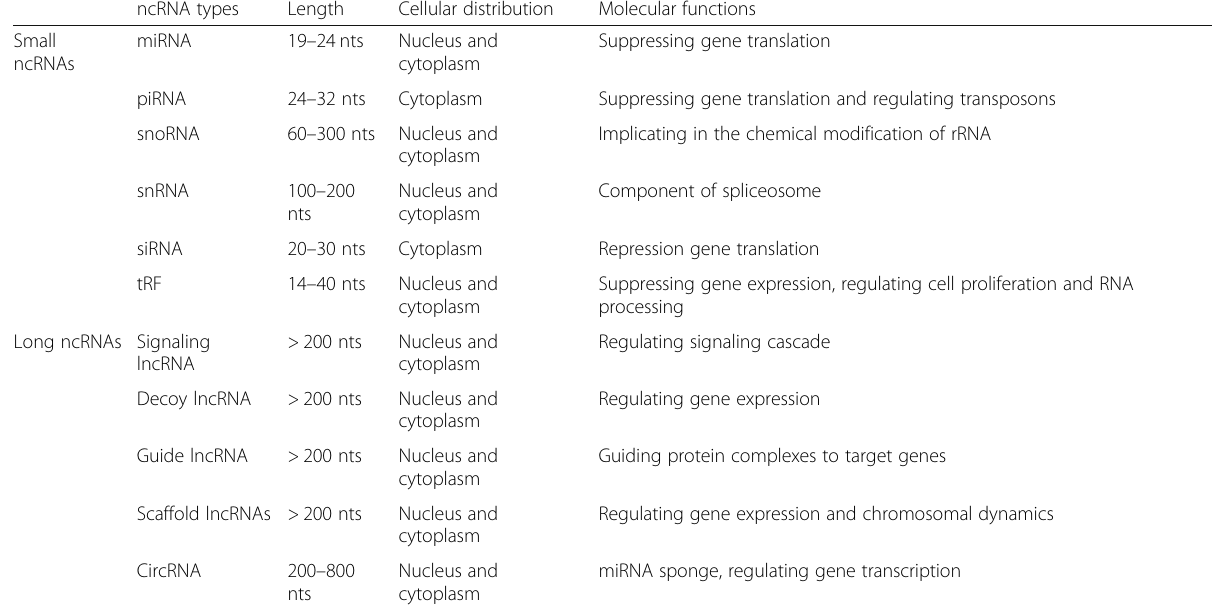
Table 1 General characterization and function of main